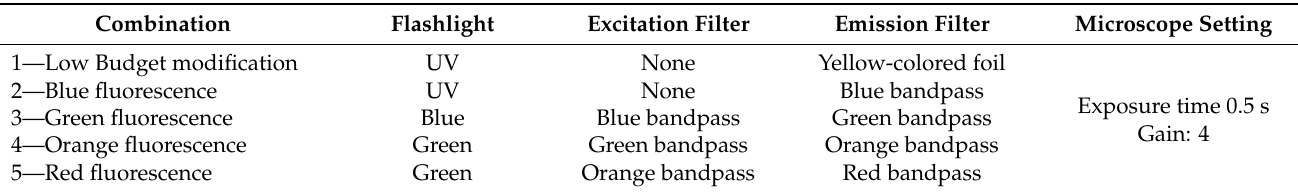
Table 4. Combination of lamps and filters used for fluorescent imaging.